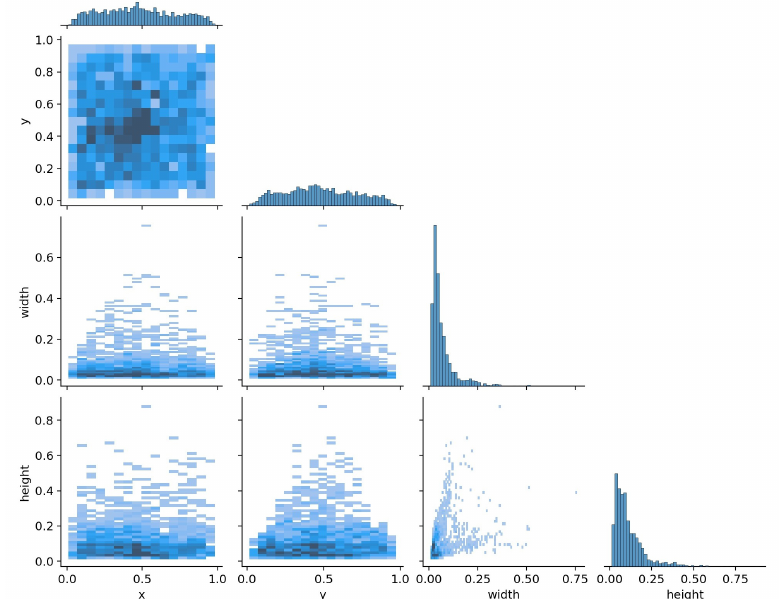
Figure 7. The location distribution of the dataset instances ( x - and y -values of the center point), and the correlation distribution of the width and height of the ground true bounding